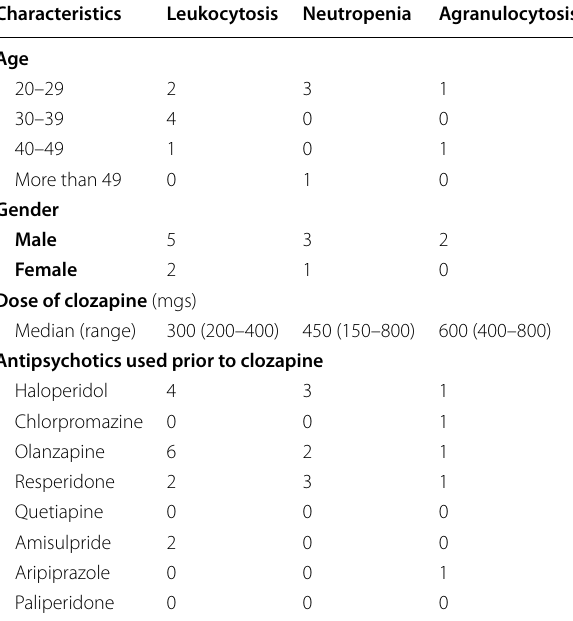
TRS Treatment-resistant schizophrenia, TRSAD Treatment resistant schizoaffective disorder, TRBD Treatment-resistant bipolar disorder, TD Tardive dyskinesia, Parkinsons with PF Parkinsons with psychotic features, PD psychotic depression Table 5 Profile of patients with hematological side